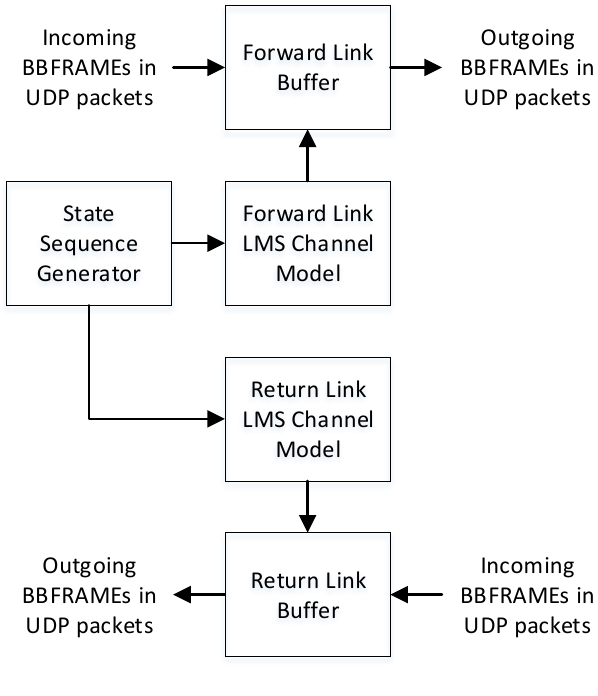
Figure 10. Satellite forward- and return-link emulator